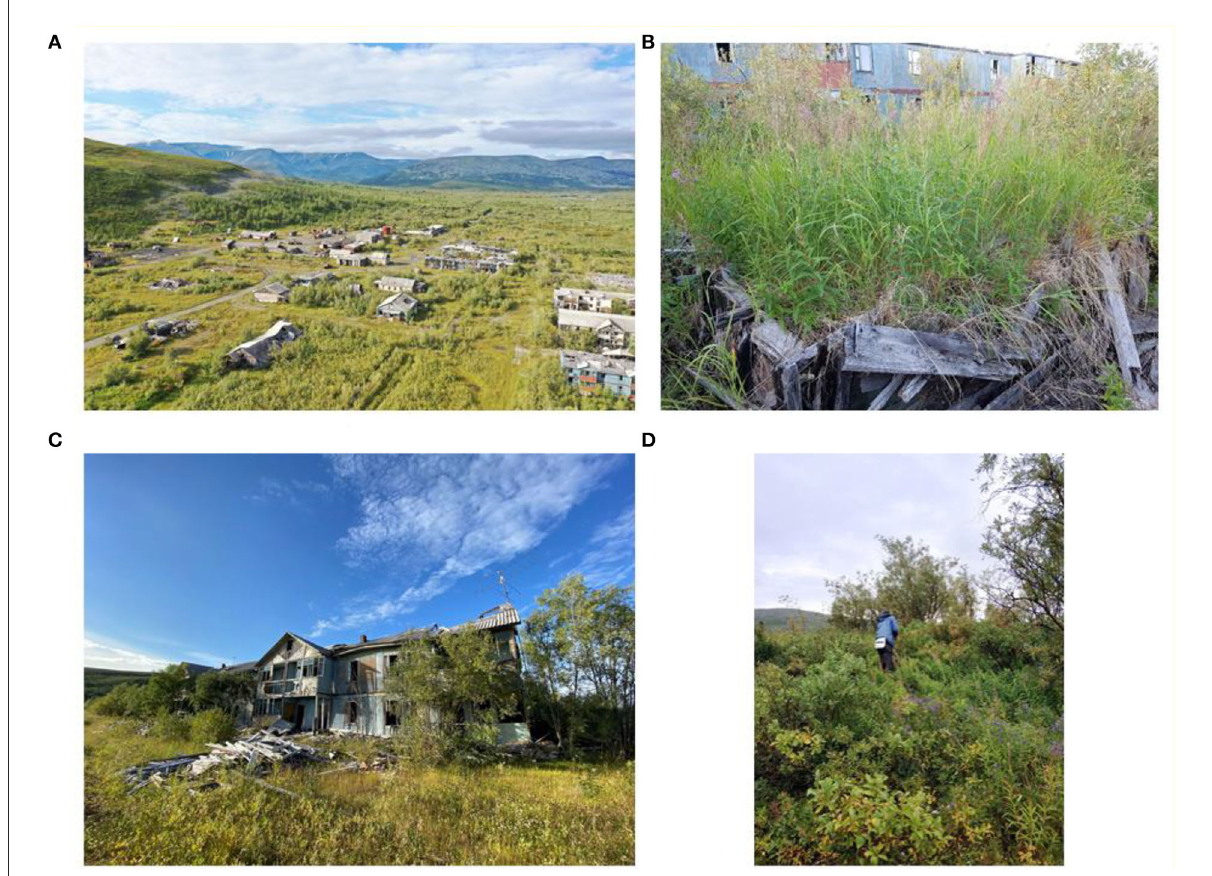
FIGURE4 Abandoned the village of Polyarny. (A,B) Photographs of the abandoned village of Polarny. (C) Abandoned greenhouse. (D) Abandoned vegetable